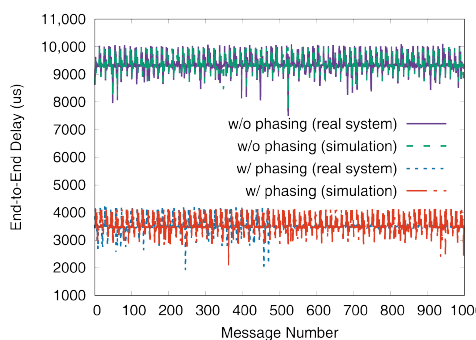
Figure 21. D e 2 e distribution of VC 0 in test set 2.